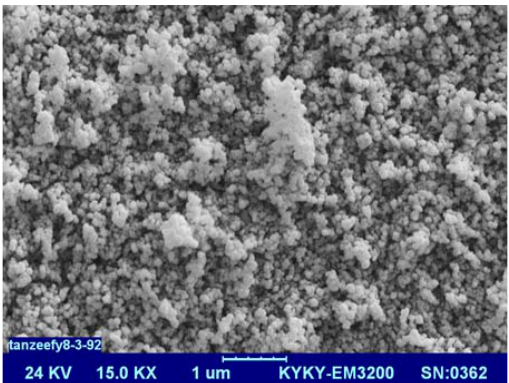
Fig. 1: Scanning electron micrograph of titanium dioxide nanoparticles.